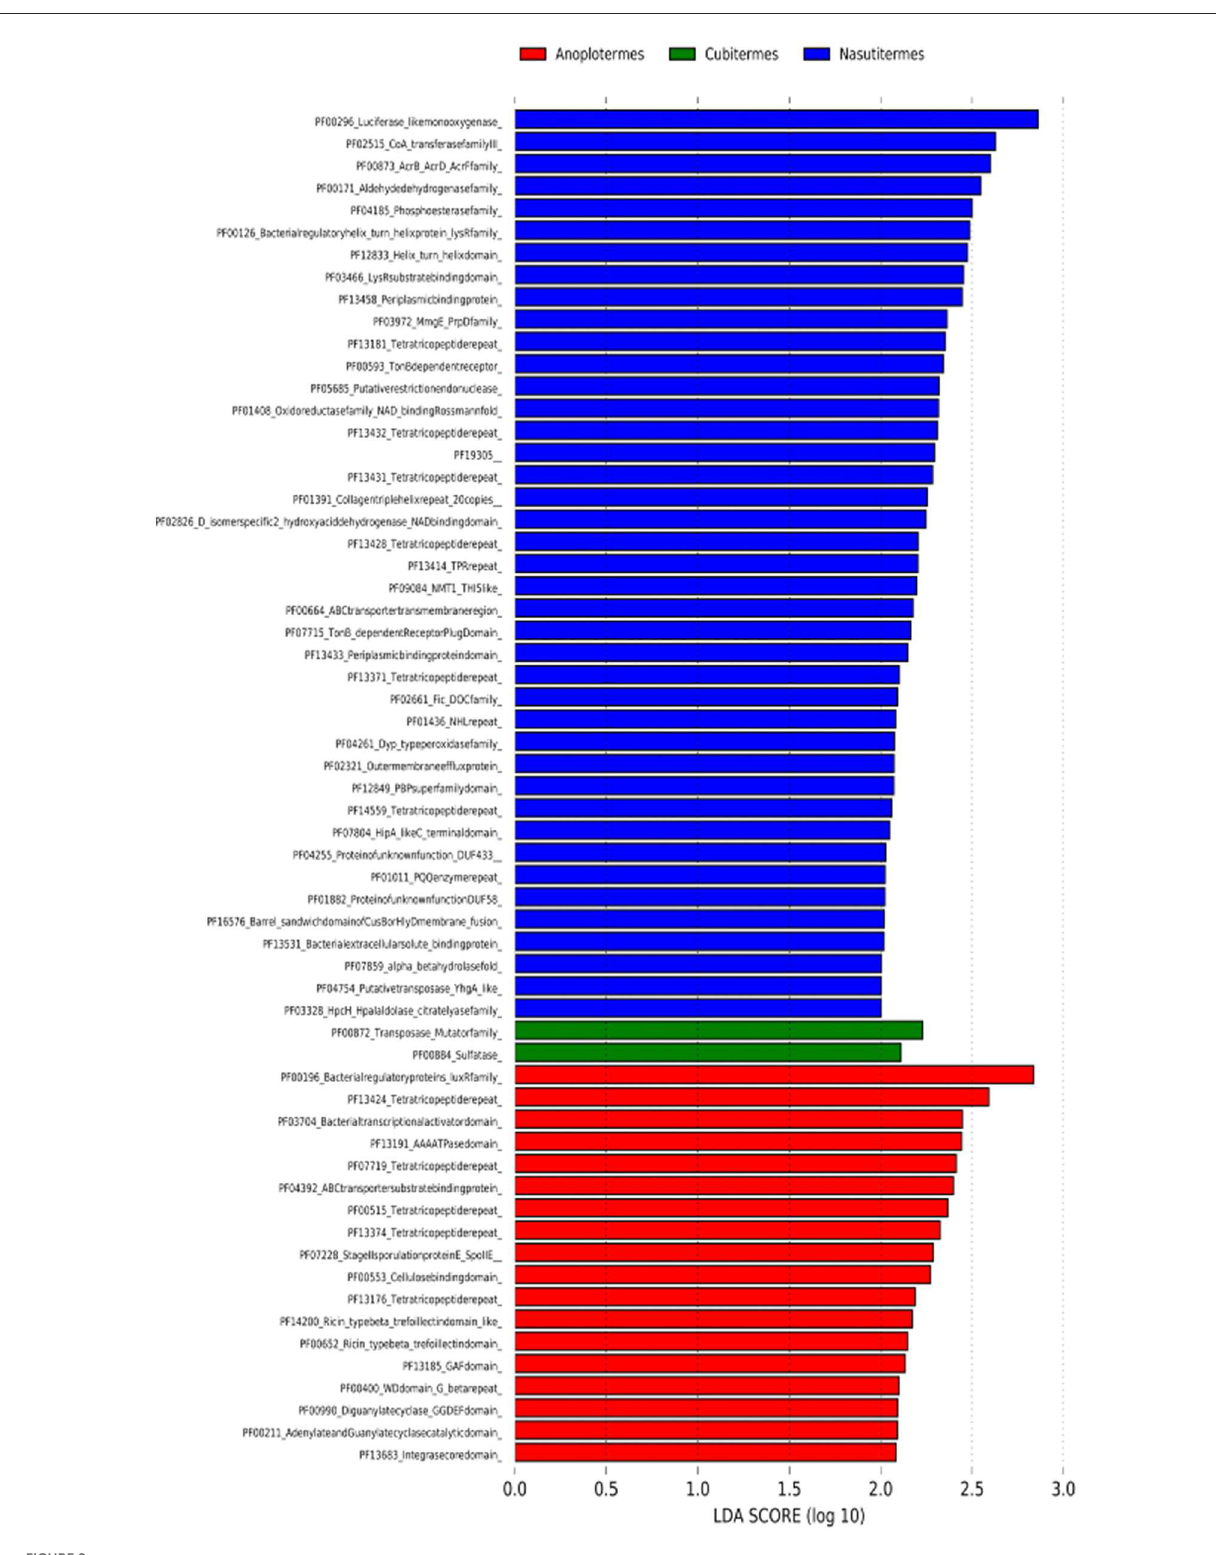
anaerobic bacteria (Bowman, 2011) that can form resistant spores (Paredes-Sabja et al., 2011), described as thermophilic ethanologens capable of fermenting lignocellulosic biomass (Arora et al., 2019),